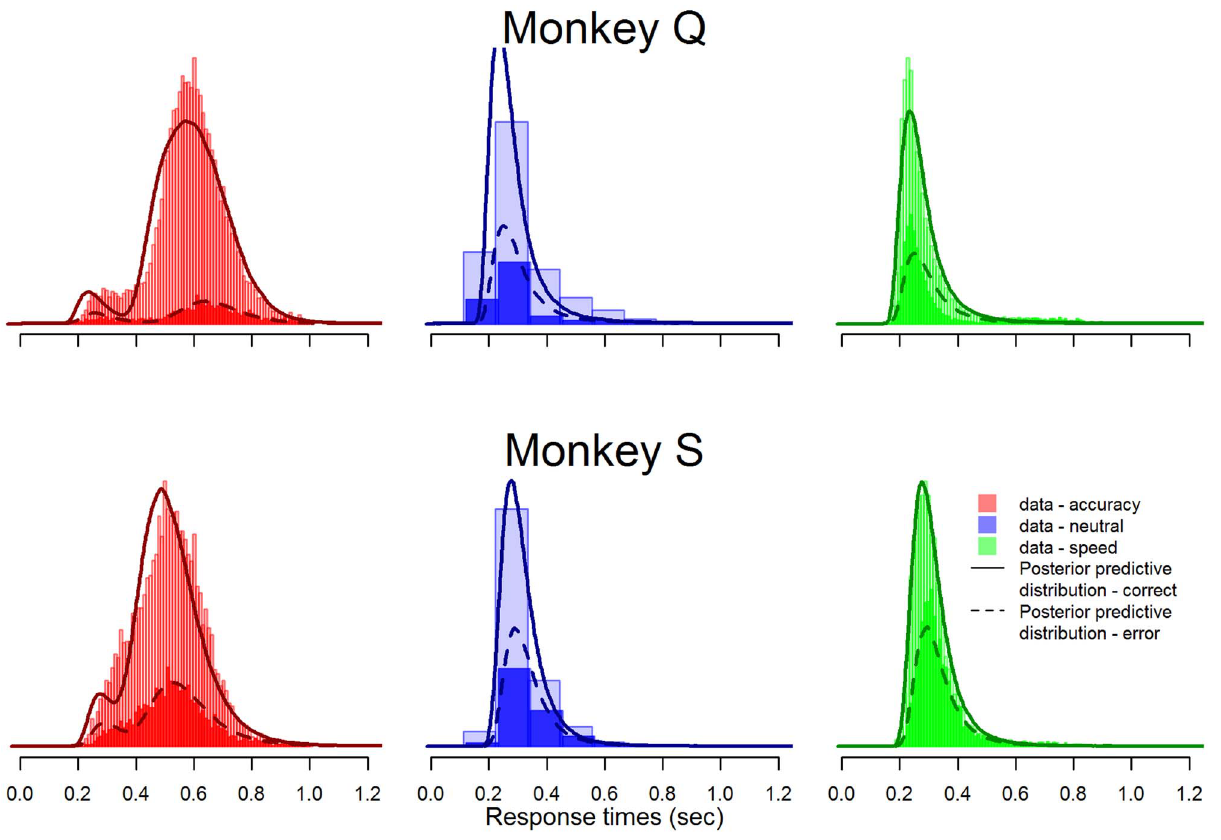
Figure 2. Joint probability distribution functions over response time and choice. Observed data are shown by coloured histograms. Lightly shaded histrograms represent correct responses with superimposed darker histograms representing incorrect responses. Model posterior predictive distributions are overlaid as lines.